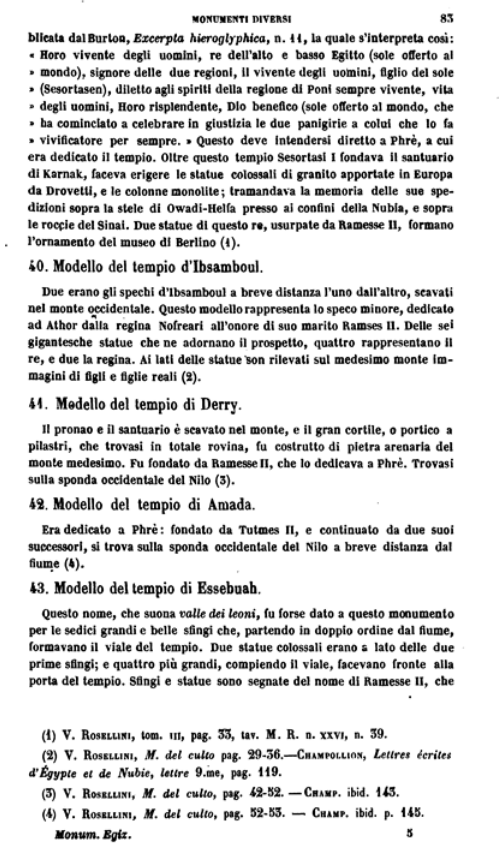
Figure 4. A page from the Orcurti catalogue